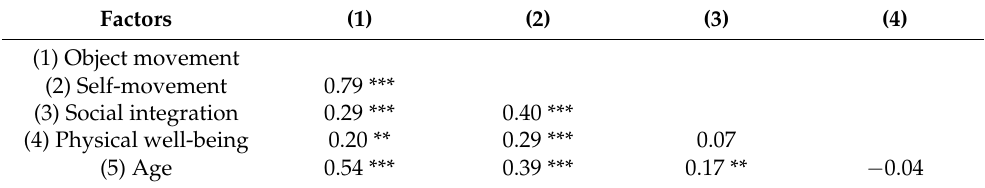
Table 6. Intercorrelations between the variables in model 3 (subsample 2).